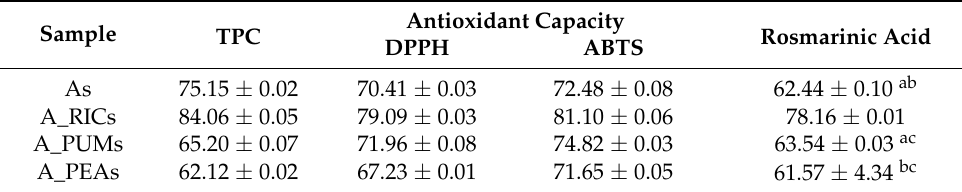
Table 2. Encapsulation efficiency (%) of formulated